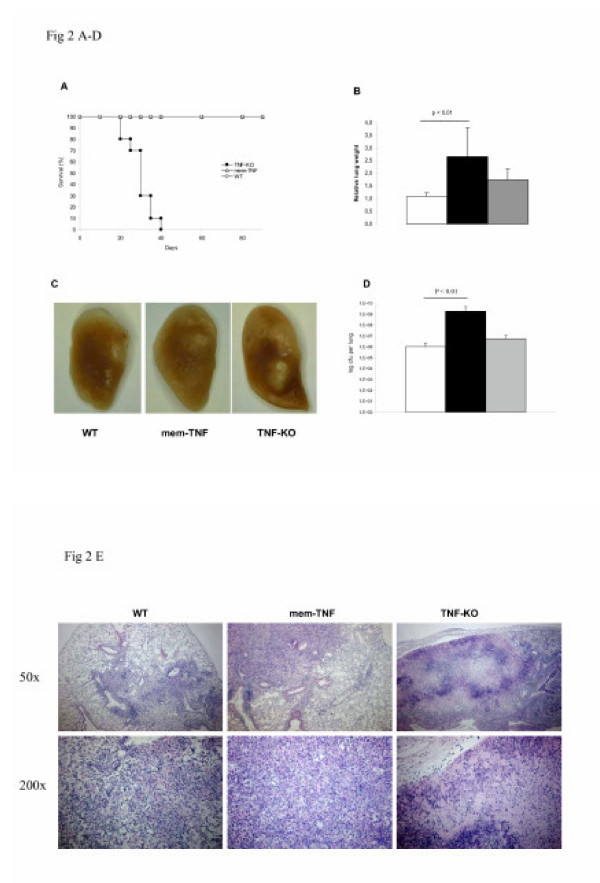
Necrotic pneumonia and uncontrolled infection in TNF-KO mice, but not in mem-TNF mice at 30 days after Mtb infection (100 CFU, intranasal administration). Survival (A), relative lung weights (B), macroscopic lung changes (C), and bacterial load at 30 days in the lungs (D). The results are expressed as the mean ± SD (n = 6 per group) and are representative of two independent experiments. The bacterial load at day 1 upon infection was 84 ± 28 CFU per lung (n = 6). Microscopic investigations of the lungs show confluent neutrophil and mononuclear cell inflammation with extensive, confluent necrosis and abundant bacilli in TNF-KO mice, while mem-TNF and WT mice show focal, largely perivascular mononuclear cell infiltration (E). Representative haematoxylin and eosin stained lung sections at low (50×) and high power (200×) are shown (n = 5 per group).